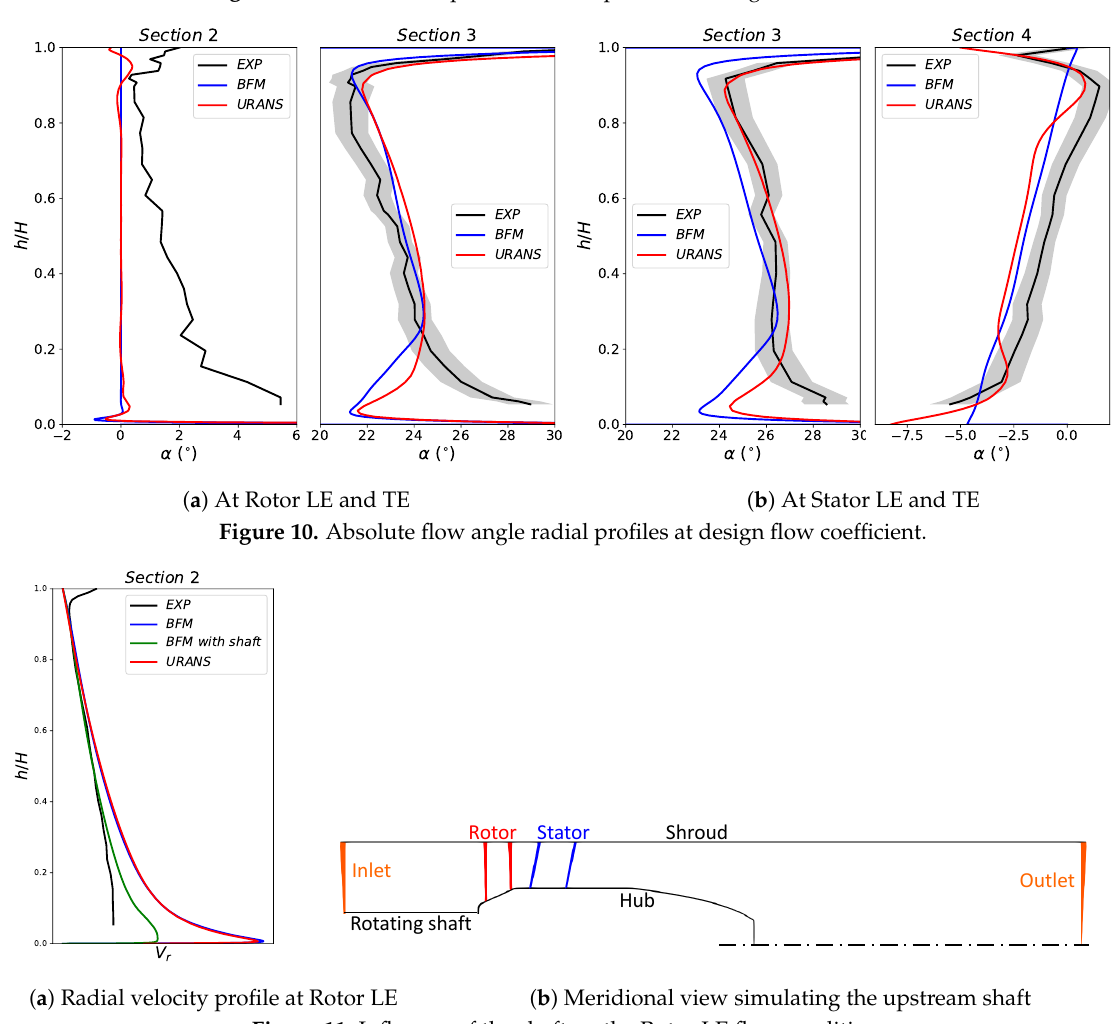
Figure 9. Absolute total pressure radial profiles at design flow coefficient.